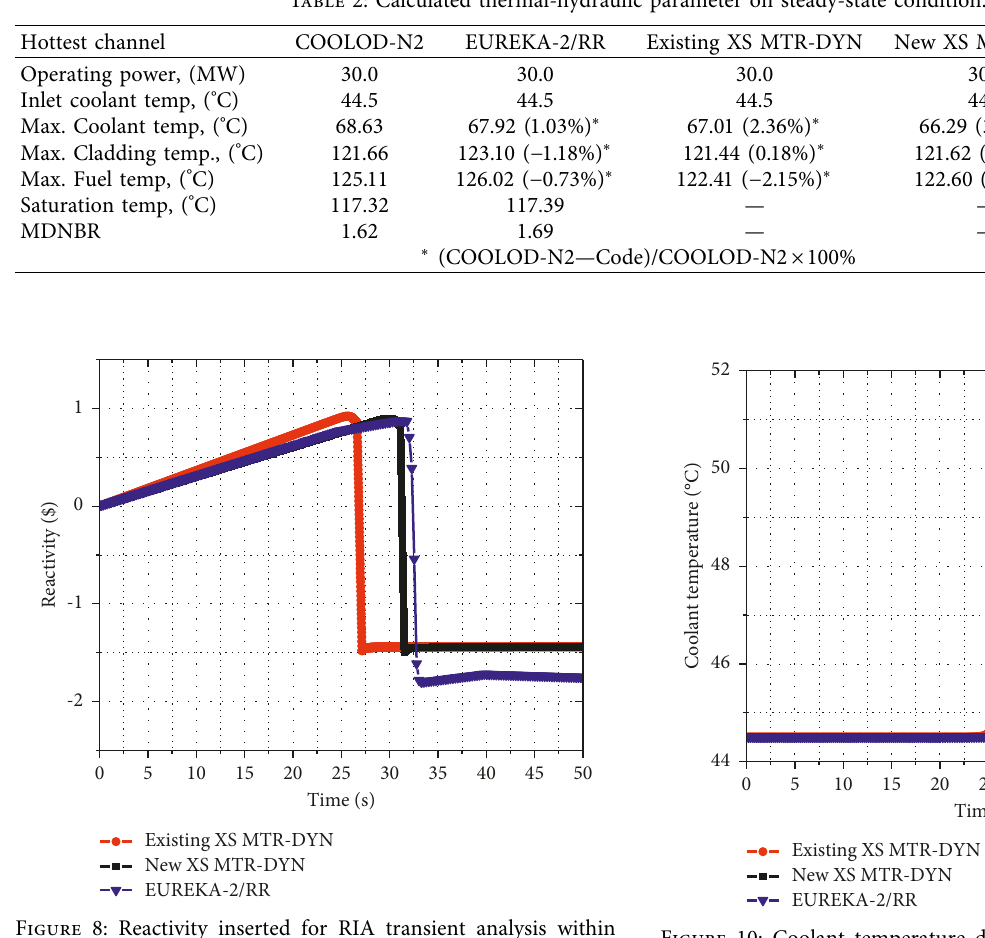
Figure 10: Coolant temperature during RIA transient at initial power 1W.